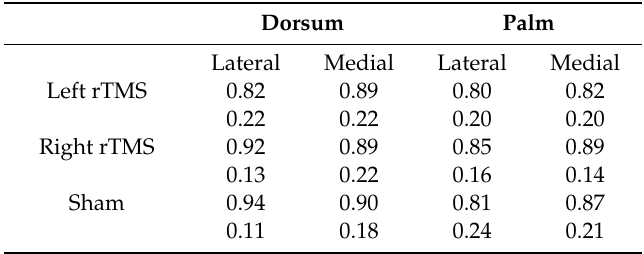
Table 3. Mean accuracy and SD, separately for hand view (dorsum and palm), hand position (lateral and medial), and stimulation condition (left, right, and sham). Dorsum Palm Lateral Medial Lateral